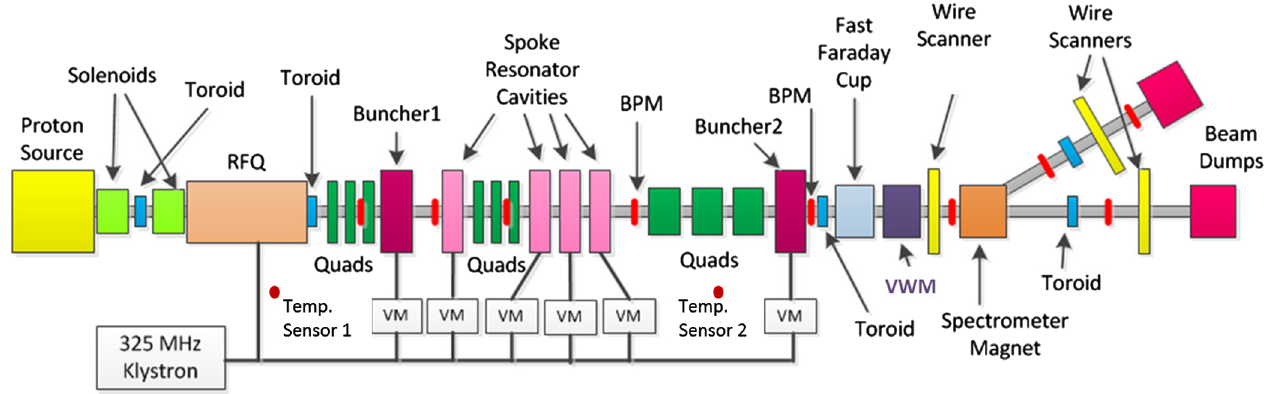
FIG. 10. Block diagram of the HINS beam line configuration used for the beam test of the LA-VWM. The ambient temperature is monitored by the two temperature sensors shown in red circles.